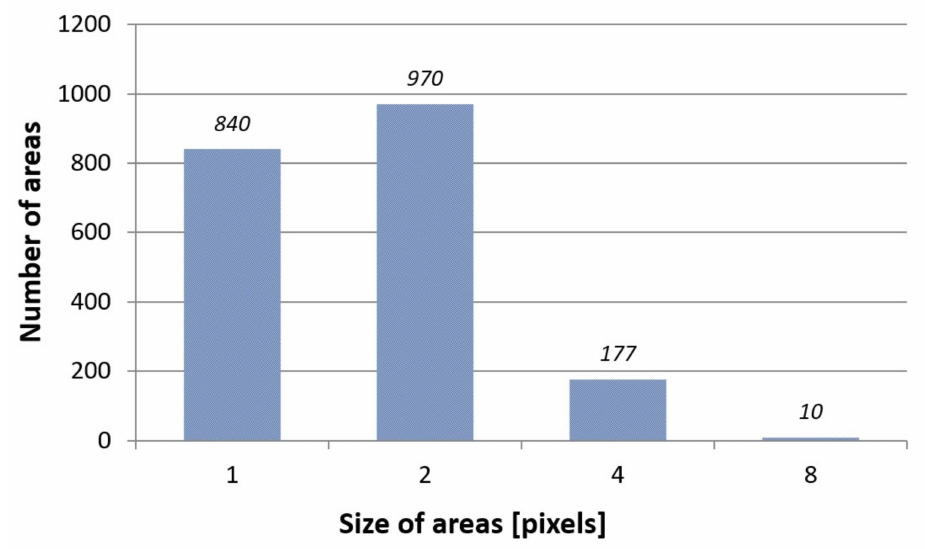
Figure 7. Histogram of the number of square areas in quadtree decomposition for the brightness threshold of one GF sample.